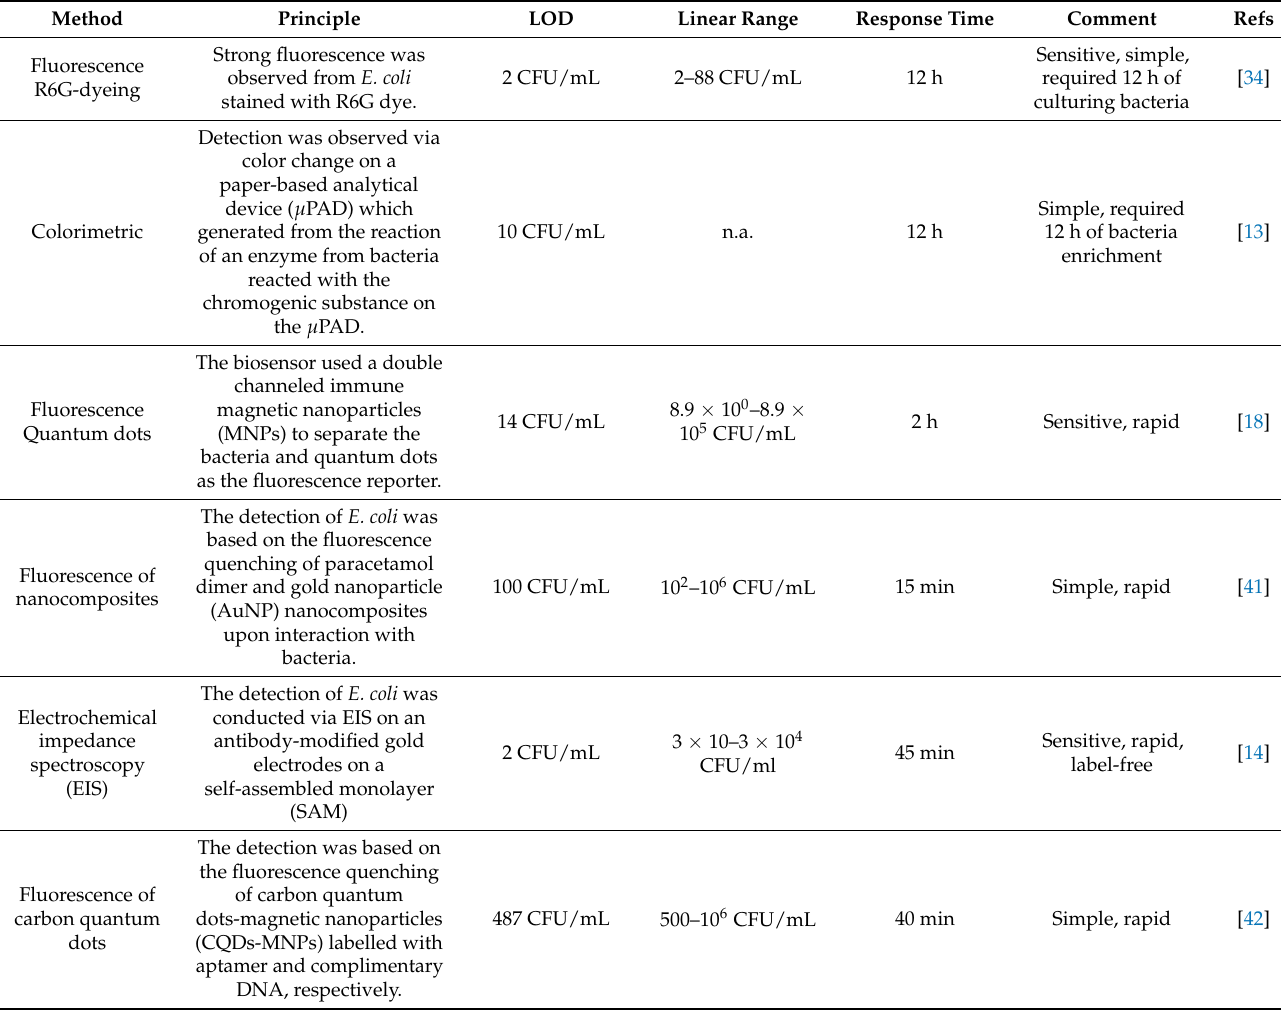
Table 2. Comparison of different methods for the detection of E. coli